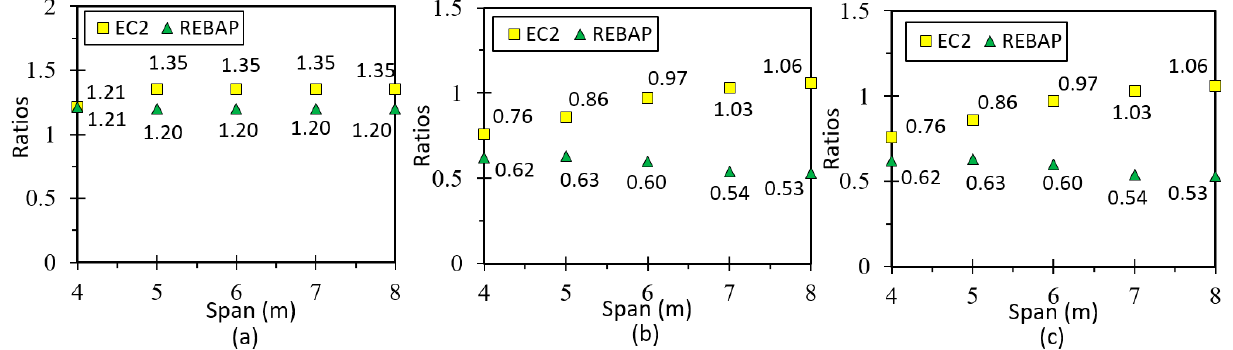
Figure 24. Ratios values for ( a ) LM, ( b ) 1NLM and ( c ) 2NLM, for flat slab.